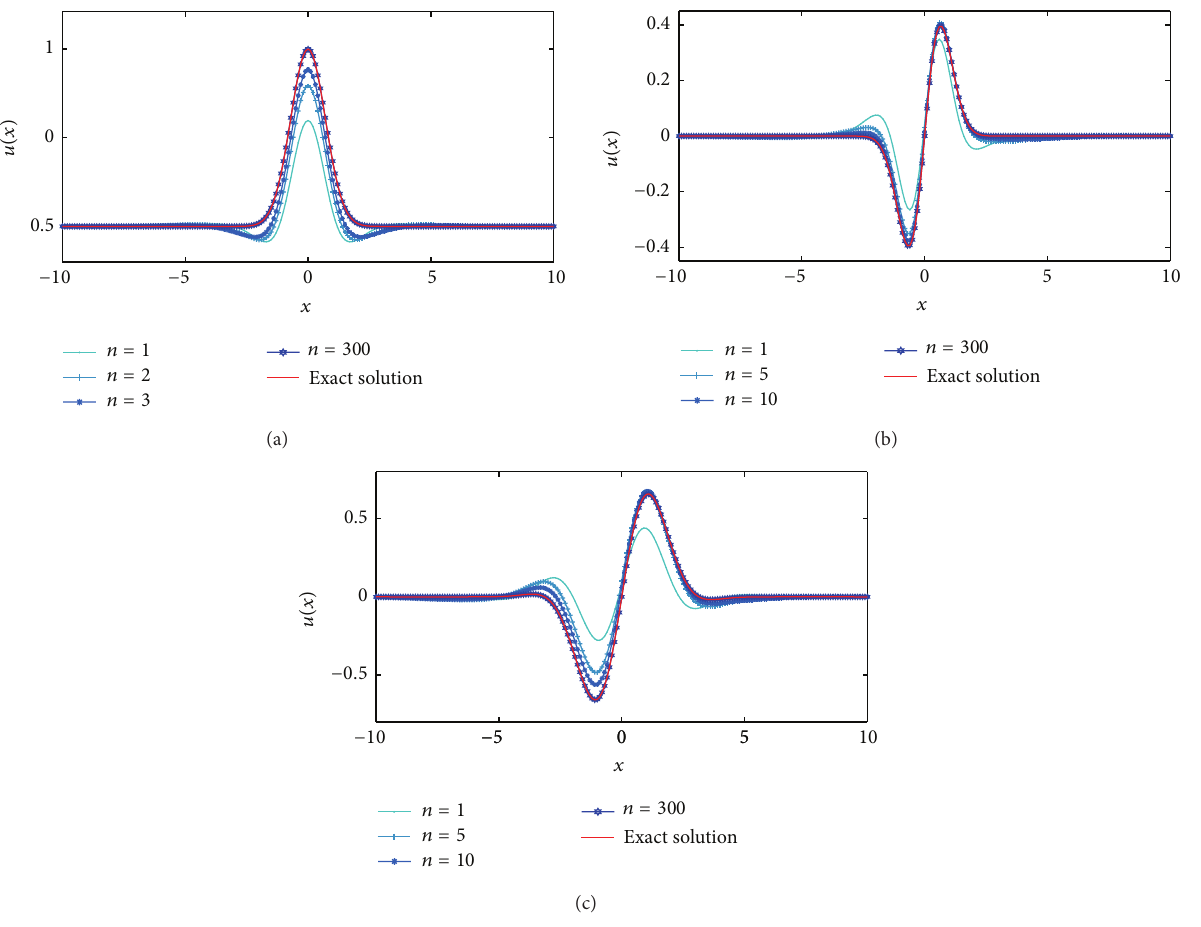
Figure 6: Convergence behaviors of the iterative